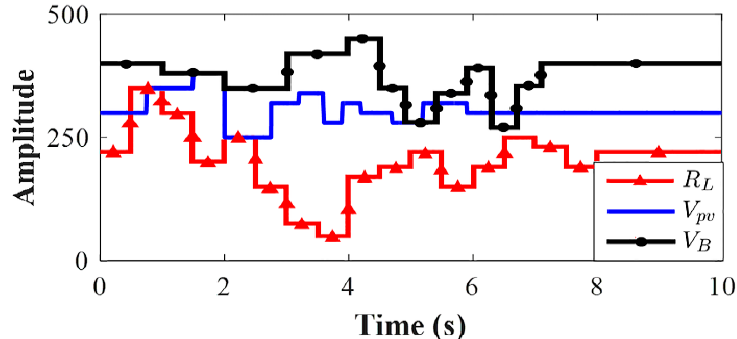
Figure 5. Voltage of C 1 and C 4 Capacitors in the presence of state-dependent Riccati equation (SDRE) controller. Figure 6. PV panel array and battery voltage in the presence of SDRE controller. Figures 7 and 8 show the capacitor-banks voltage and current variations during power generation and load changes. As can be seen, in spite of significant disturbances, the proposed controller has returned the voltage and current to equilibrium points within a few seconds and maintained the stability of the system. Figure 9 shows the dc bus voltage, which, in spite of the disturbances in the system, the SDRE controller was able to regulate properly the voltage and system stability was ensured. As can be seen, the control input range is small in spite of the high variations in the PV panel system output voltage, the battery, and the capacitor bank, as well as the load variation. The results of the simulations indicate the capability of the proposed method for the islanded dc microgrids and exposed to disturbances. In this work, the criterion of return to the initial equilibrium point after the end of the disturbance is proposed as a dc microgrid stability index. As can be seen in Figures 5–9, voltage and current values return back to their respective equilibrium values prior to the disturbance occurrence.